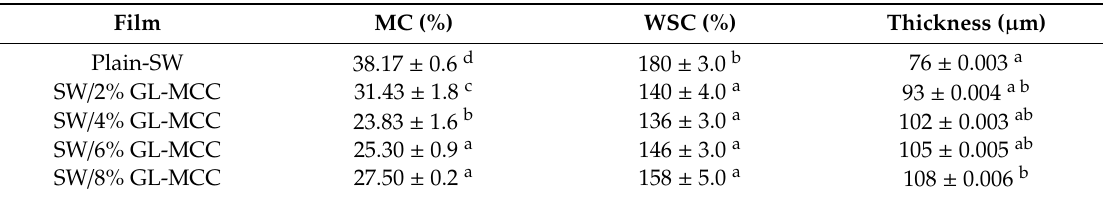
Table 1. Moisture content, water sorption capacity, and thickness of macroalgae / GL-MCC biopolymer films.